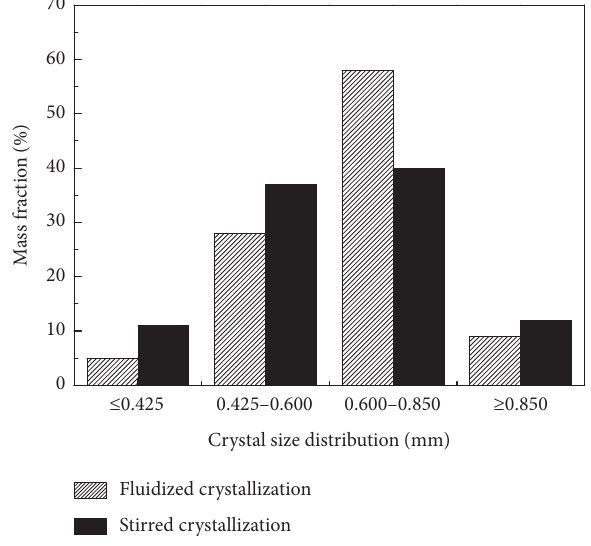
Figure 14: Effect of different phase ratios on crystal size